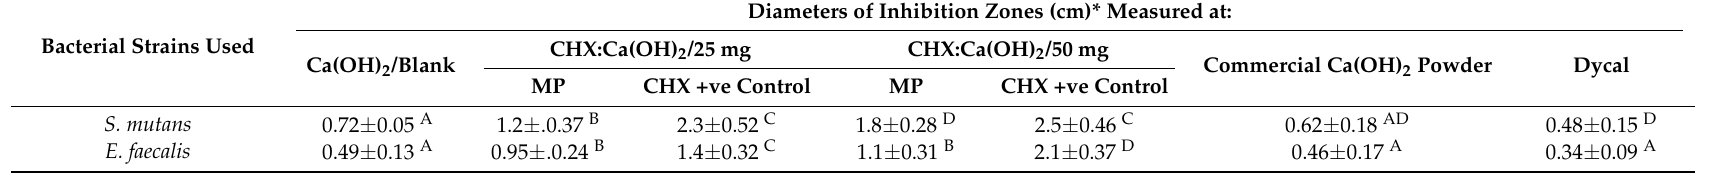
Table 2. Inhibition zone diameters obtained from agar disk diffusion assay with S. mutans and E. faecalis in the presence of Dycal, the commercial Ca(OH) 2 powder, the Ca(OH) 2 /Blank microparticles, the different formulations of CHX-loaded/Ca(OH) 2 microparticles and the corresponding unencapsulated CHX (positive